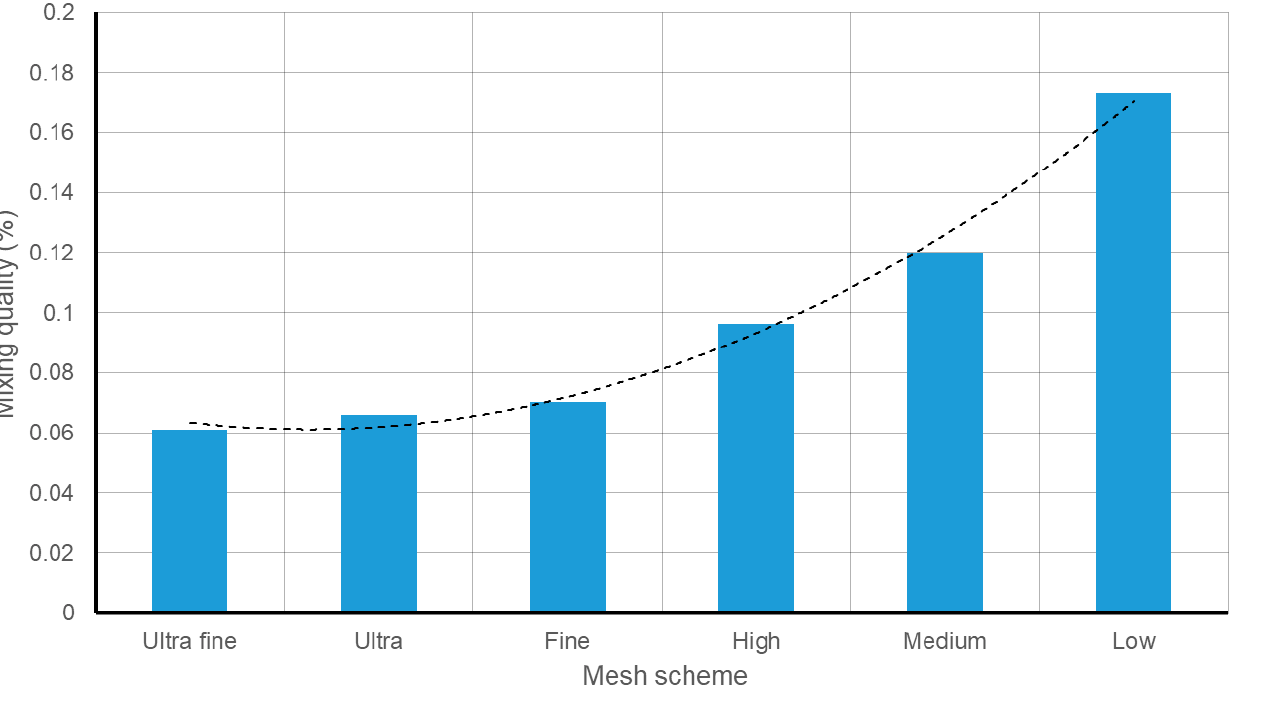
Figure 4. Mixing quality based on the applied mesh scheme.